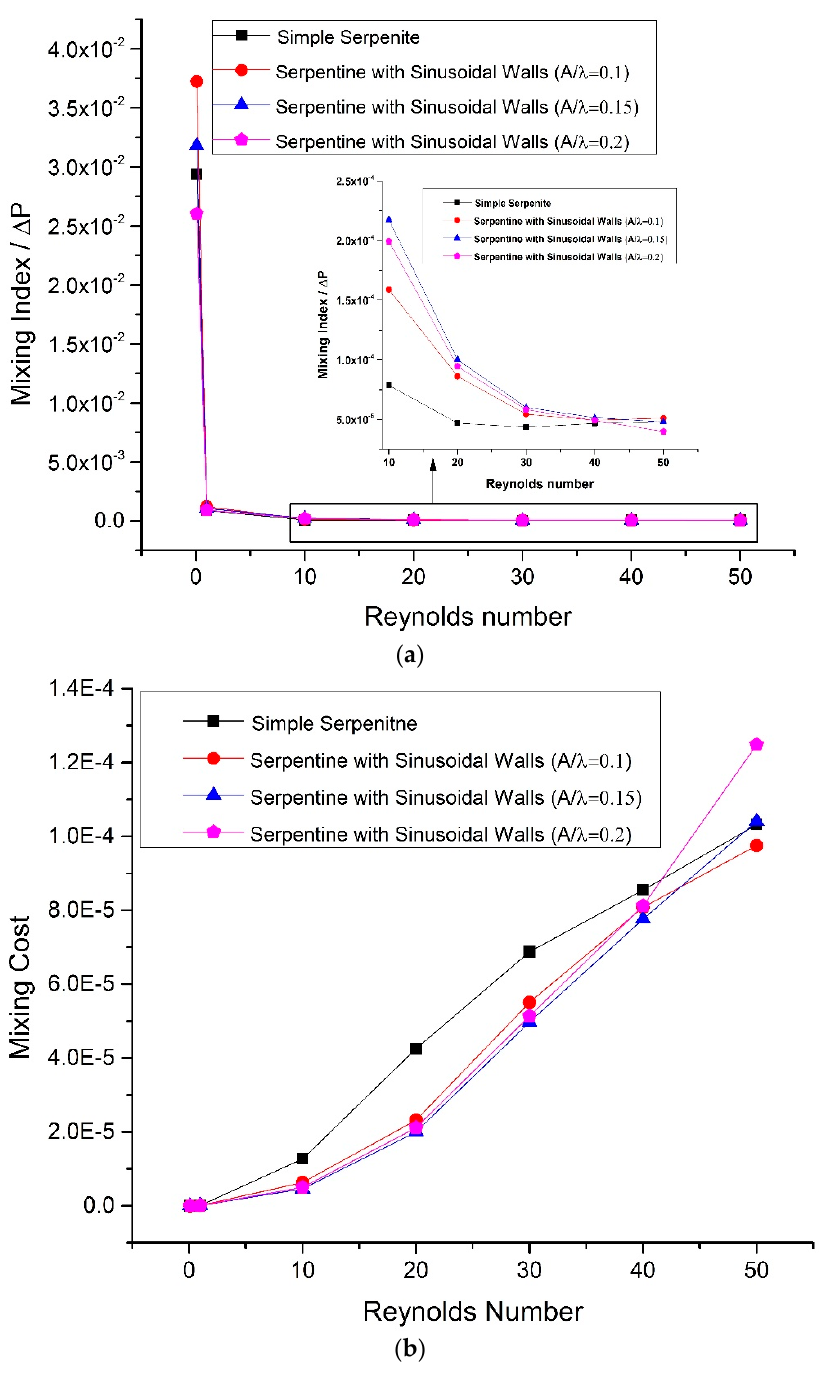
Figure 10. Mixing cost in terms of ( a ) pressure drop and ( b ) input power.